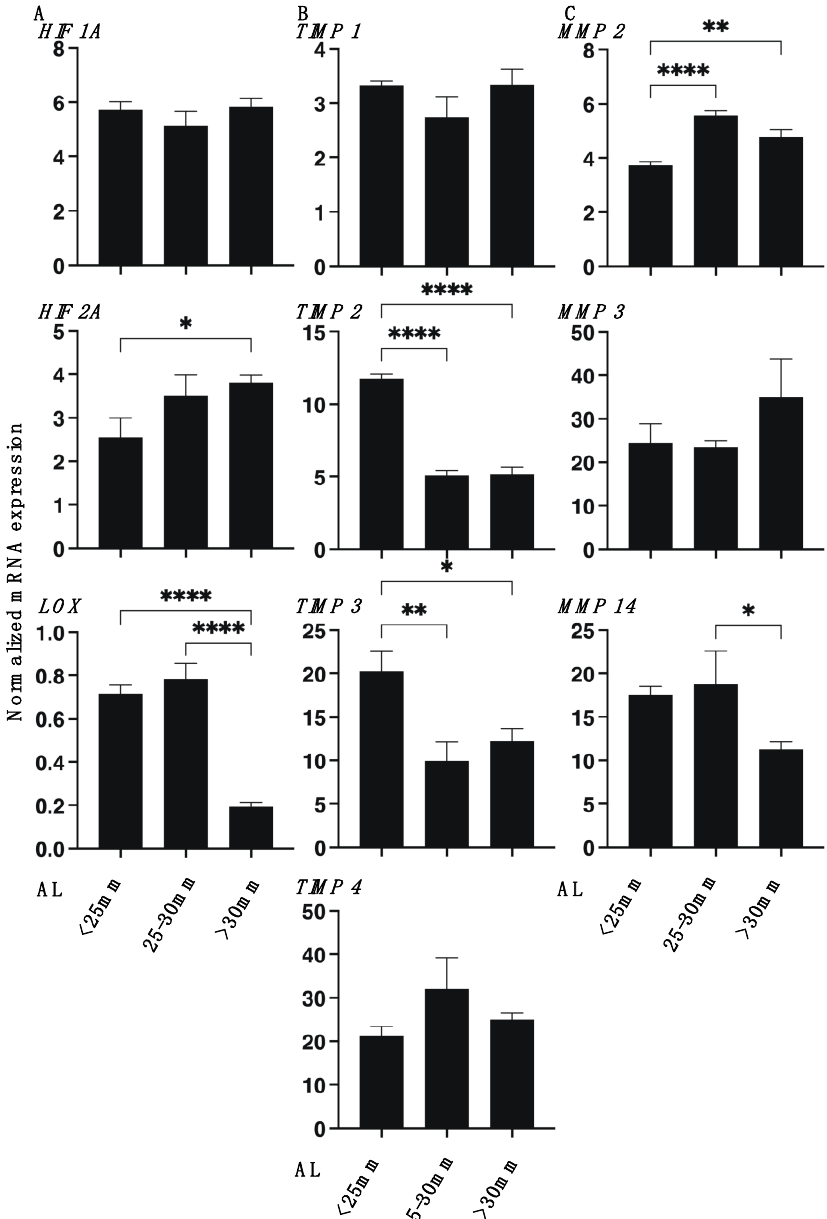
Figure 5. mRNA expression of HIF 1A, HIF 2A, LOX ( A ), TIMPs (1–4) ( B ), and MMPs (2, 9, 14) ( C ) in 3D spheroids derived from human scleral stroma fibroblasts (HSSFs). The three different ALs <25 mm, 25–30 mm, or >30 mm of 3D spheroids of HSSFs were subjected to qPCR analysis at Day 5 and the mRNA expression of HIF 1A , HIF 2A , LOX ( panel A ), TIMP 1–4 ( panel B ), and MMP 2, 3, 9, and 14 ( panel C ) was estimated. No evidence for the expression of MMP9 was found. All experiments were performed in duplicate using fresh preparations ( n = 5, each). Data are presented as the arithmetic mean ± standard error of the mean (SEM). * p < 0.05, ** p < 0.01, **** p < 0.001 (ANOVA followed by Tukey’s multiple comparison